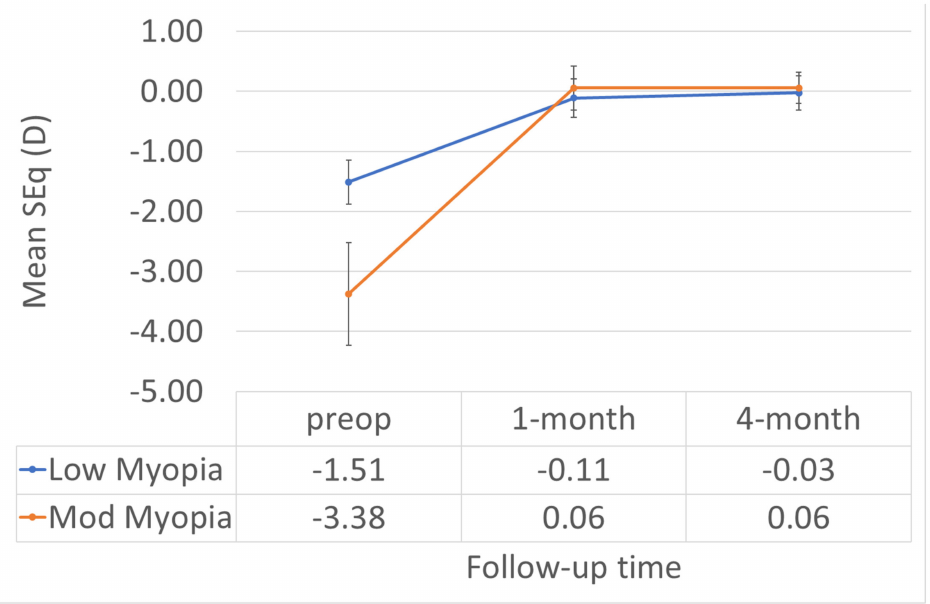
Figure 7. The SEQ did not change in a relevant manner between 1M and 4M in either